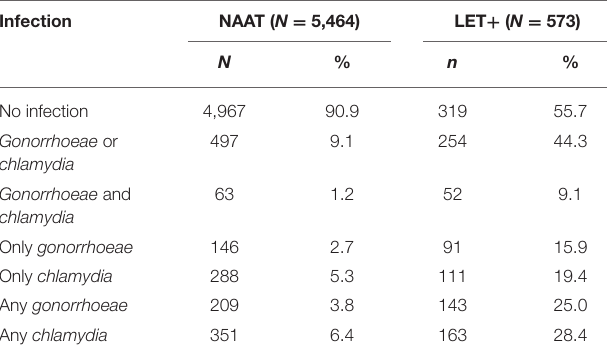
TABLE 2 | Characteristics of LET-positive patients in Guangdong, China, 2017–2019 ( N = 5,464).